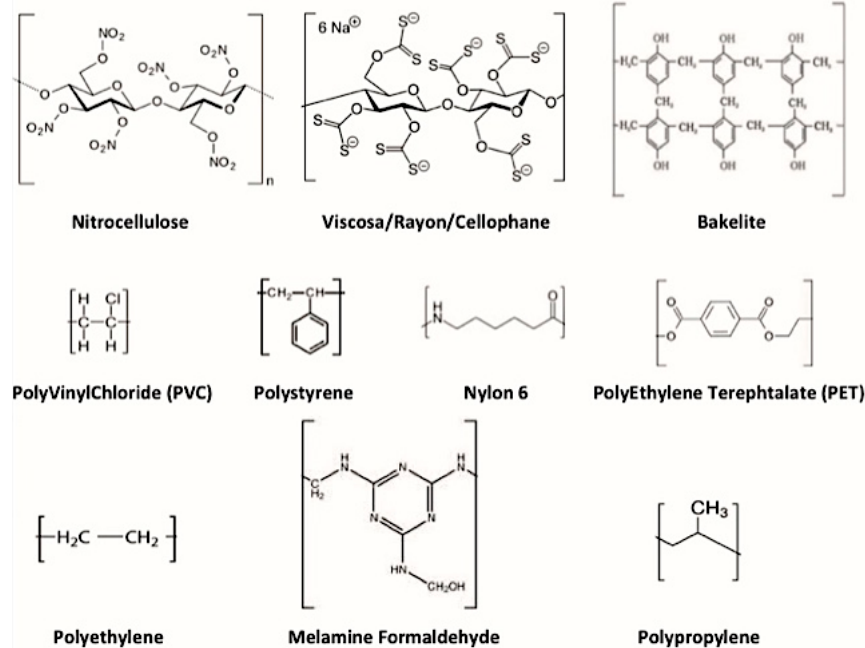
Figure 1. Repeating units of the most representative plastic polymers.